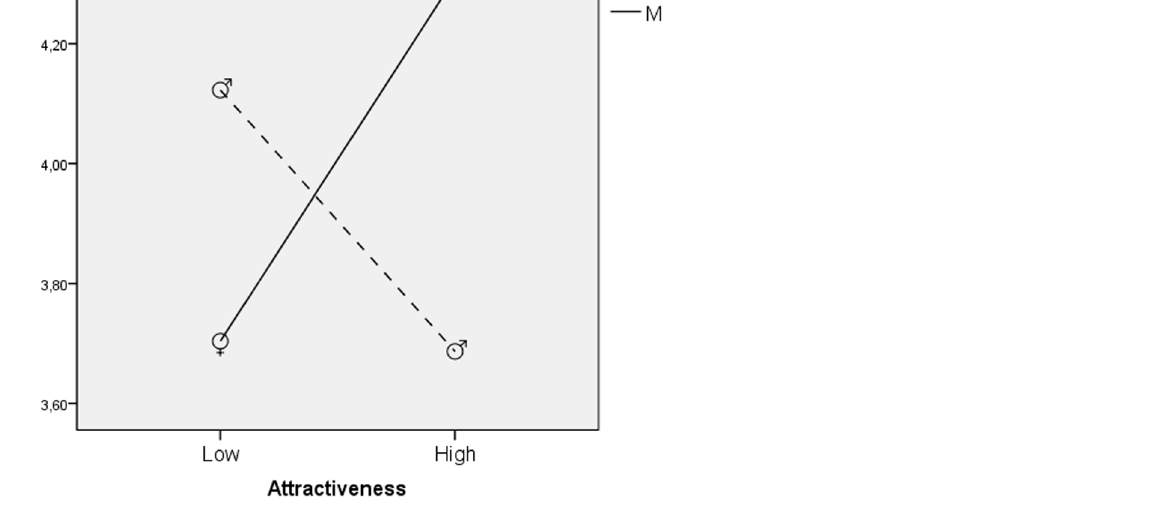
Figure 5. Interaction of attractiveness and target gender: Evaluation of the target in terms of openness mean